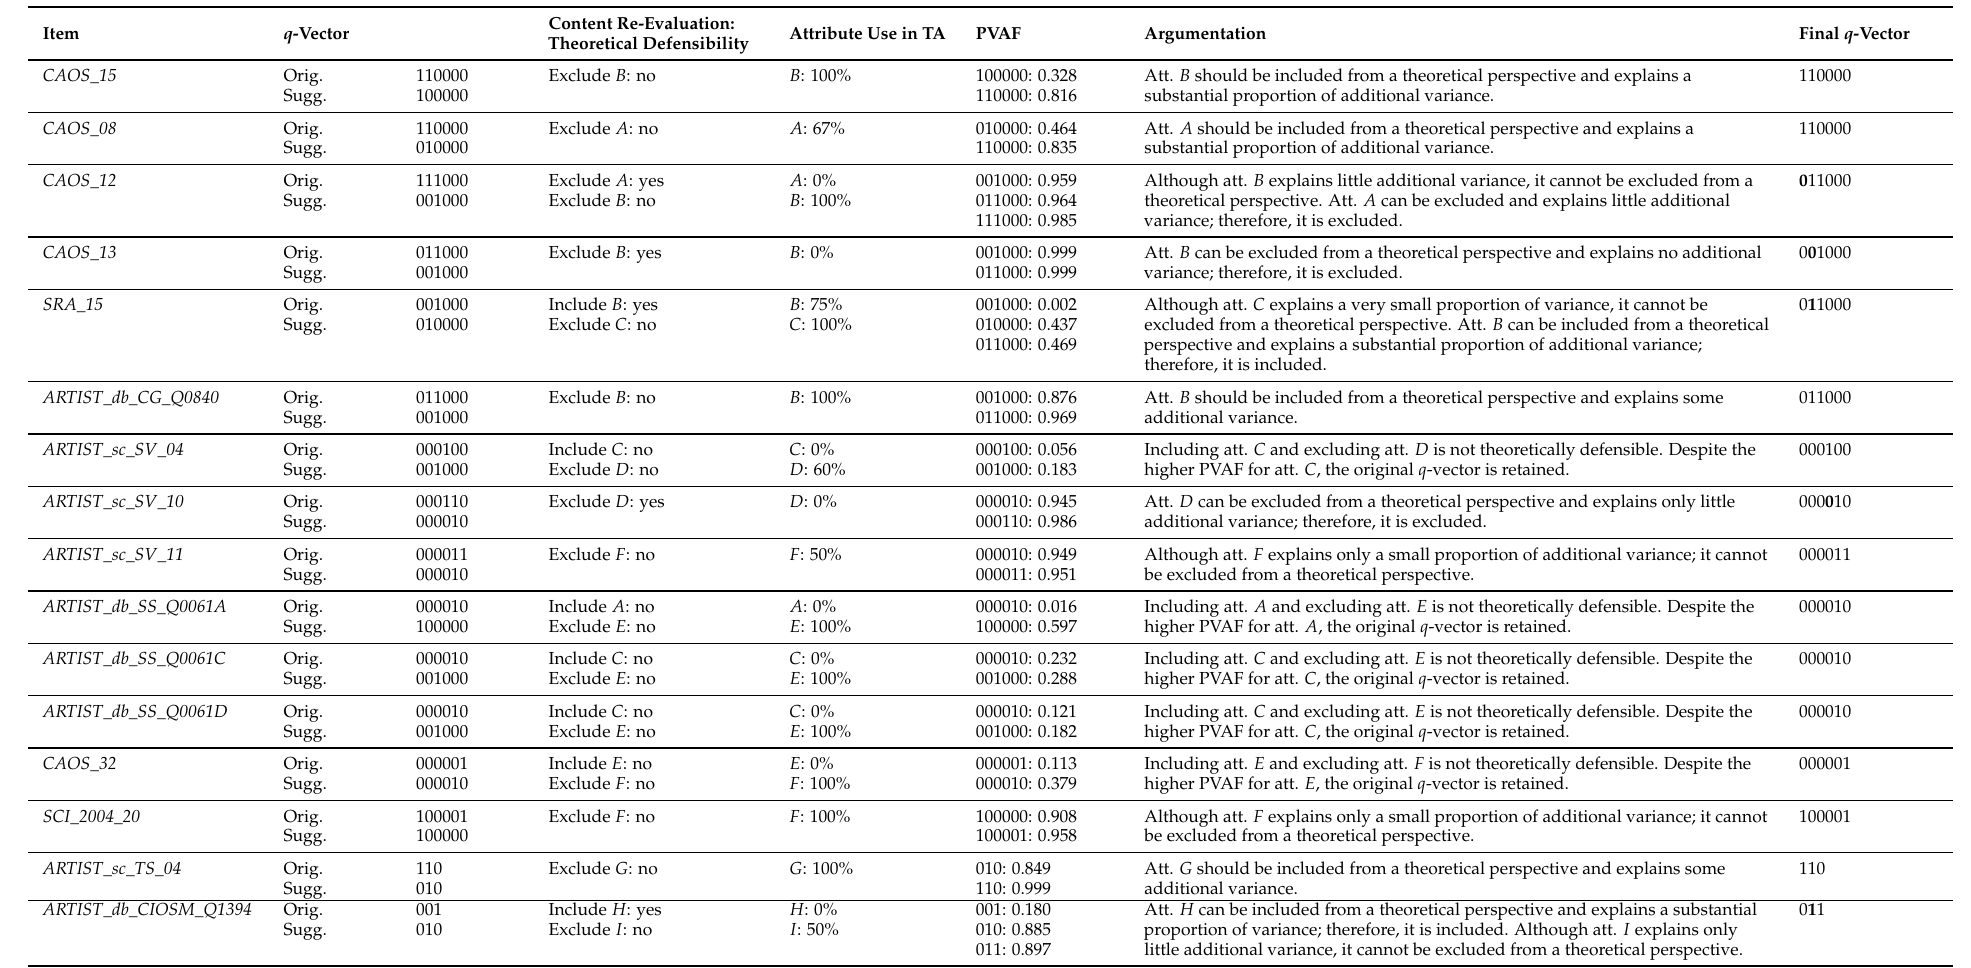
Table A2. Items for which the stepwise Wald method suggested q -vector modifications. The table shows the original and suggested q -vectors that represent rows in the Q-matrix. Further, the table shows (1) the item content re-evaluation indicating whether suggestions to include or exclude attributes could be theoretically defensible (yes/no), (2) the percentage of students in the think-aloud (TA) who used the attributes for which modifications are suggested, (3) the PVAF for relevant q -vectors, (4) the argumentation to retain or modify q -vector entries, and (5) the final q -vectors (modifications in